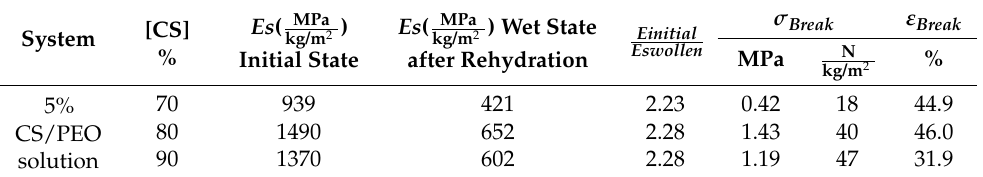
Table 4. Experimental E s values obtained by DMA on as spun and wet fiber mats after extraction of PEO (MW = 5 × 10 3 kg/mol), drying and rehydration. Uniaxial stress/strain properties on wet state are joined